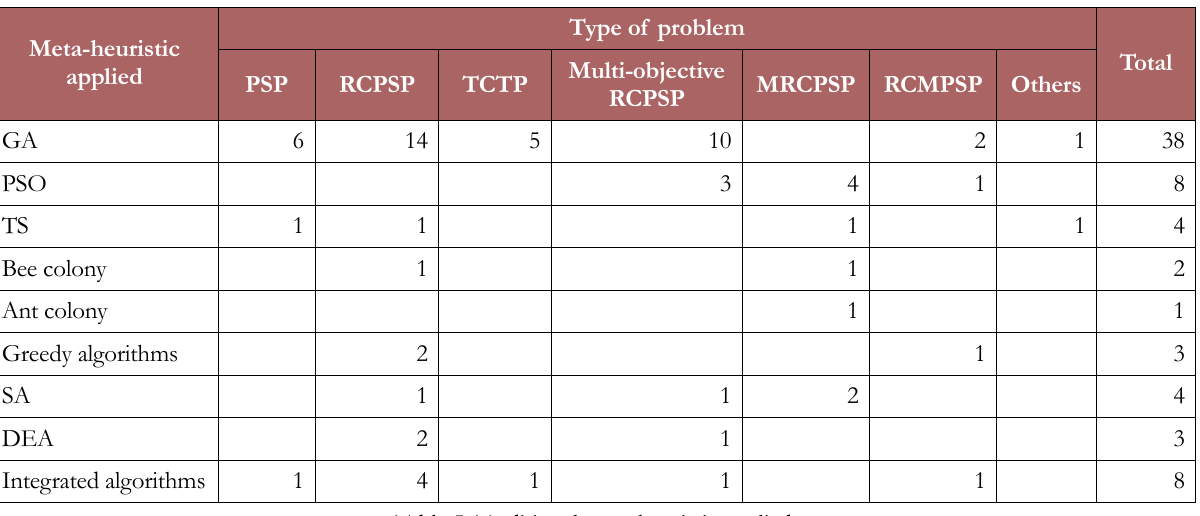
Table 5. Traditional meta-heuristic